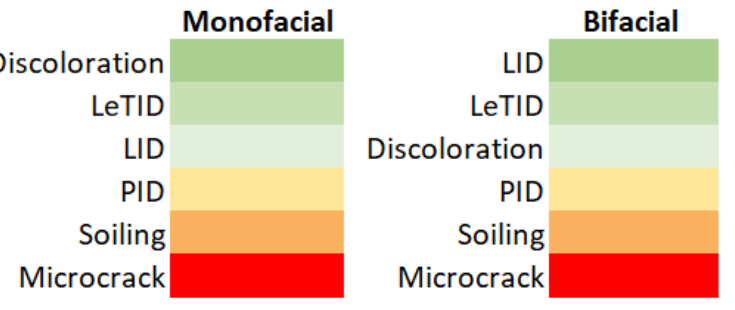
Figure 18. Degradation scale for MPV and